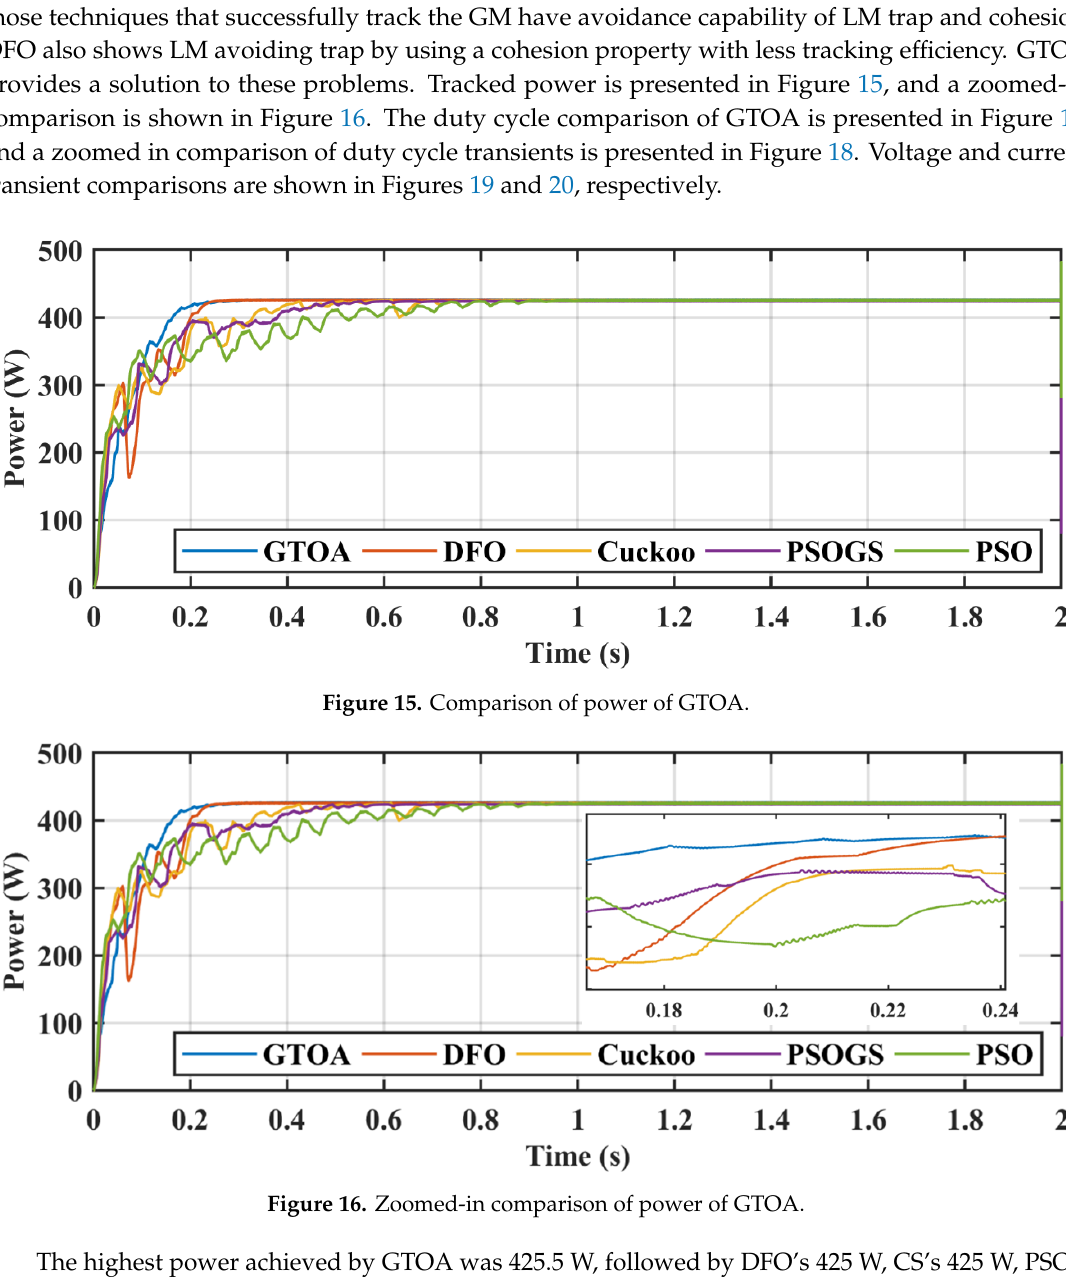
Figure 17. Comparison of duty cycle of GTOA. Figure 18. Zoomed-in comparison of duty cycle of GTOA.